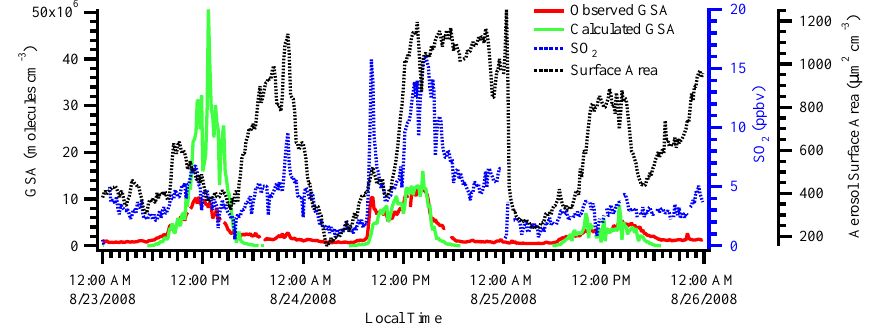
Fig. 5. Time series of both observed (red trace) and calculated (green trace) GSA from 23 to 25 August. Also shown here are the SO 2 (blue dot) and aerosol surface area (black dot) used in GSA